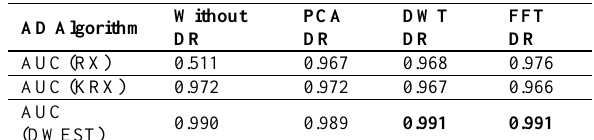
Figure 11. ROC curves of DWEST AD family for Img-II. Table 3. AUC values of the AD methods applied to Img-